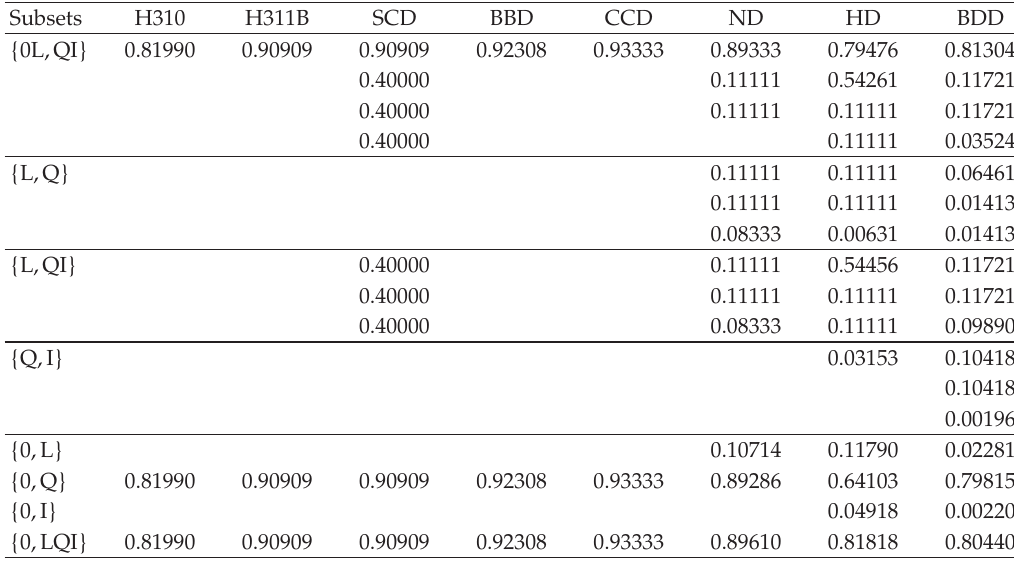
Table 2: Squared canonical correlations between designated subsets (cid:5) (cid:2) β second-order designs.